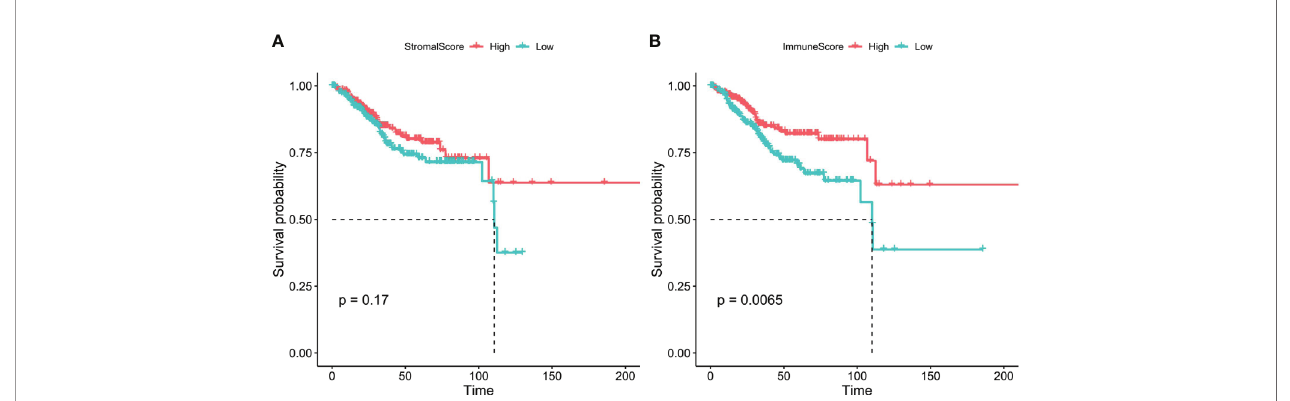
FIGURE 2 | The K-M survival curves of high and low stromal/immune scores groups. (A) Stromal scores. (B) Immune